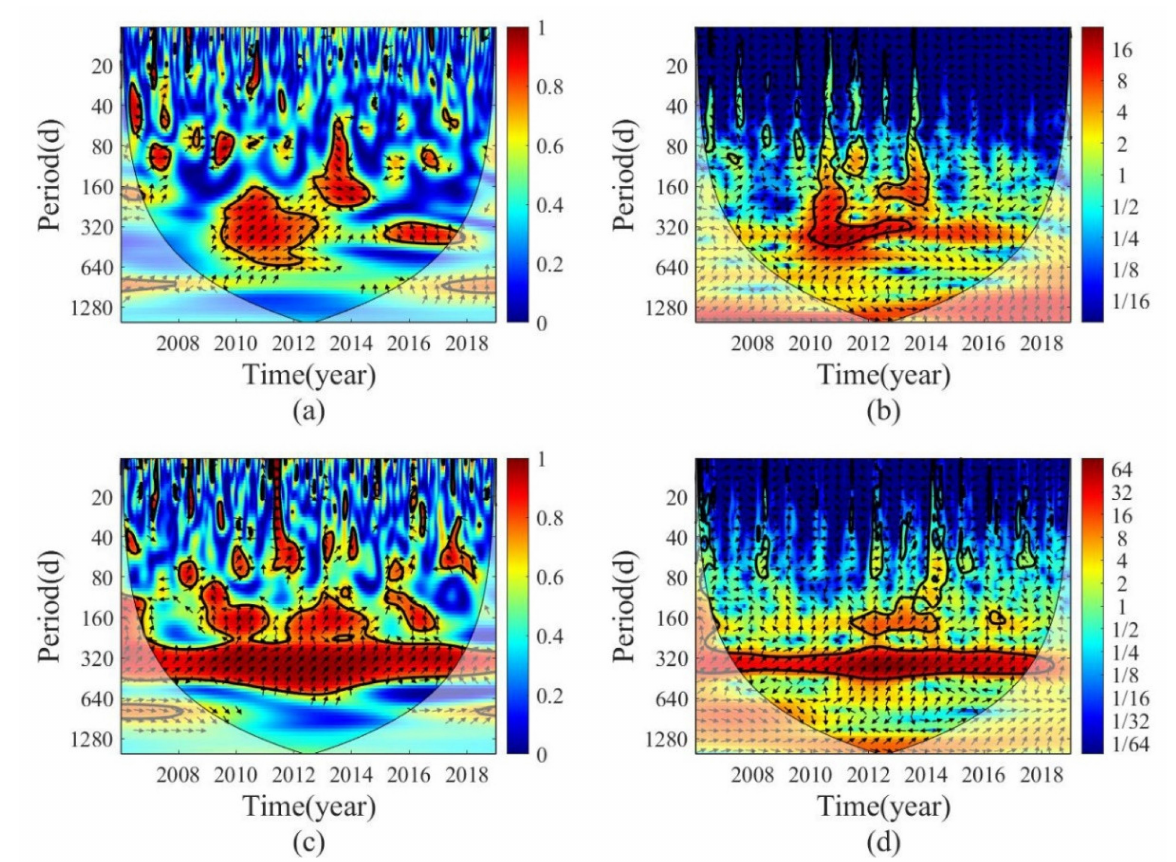
Figure 4. Cross wavelet coherence spectrum and its corresponding power spectrum between two time series for different cases: ( a ) Cross wavelet coherence spectrum without a stable oscillation period; ( b ) Cross wavelet power spectrum without a stable oscillation period; ( c ) Cross wavelet coherence spectrum with a stable oscillation period; and ( d ) Cross wavelet power spectrum with a stable oscillation